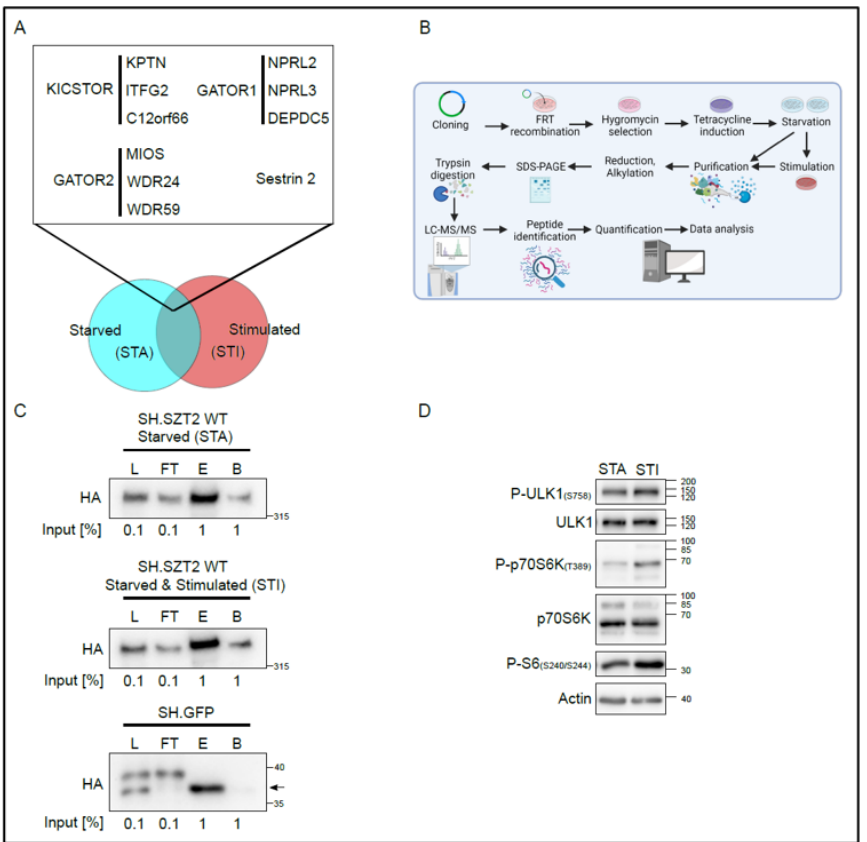
Figure 1. Establishment of the SZT2 interactome. ( A ) Graphical representation of workflow and choice of conditions. Published SZT2 binding partners associate with the protein independently of the physiological conditions, and we assume other interactors might also do so. In addition, SZT2 might bind to certain components under specific physiological conditions, e.g., starved (STA) and stimulated (STI). ( B ) Methodological workflow to decipher the SZT2 interactome under catabolic and anabolic conditions via affinity purification coupled to mass spectrometry. Image created with BioRender.com. ( C ) Quality control of the affinity purification fractions. An aliquot of specific fractions collected along the purification protocol was analyzed by Western blotting against HA; L, Lysate; FT, Flow through; E, Eluate; and B, Beads. ( D ) Lysates of a representative starved (STA) or starved and stimulated (STI) biological replicate were run on SDS-PAGE and analyzed by immunoblotting.